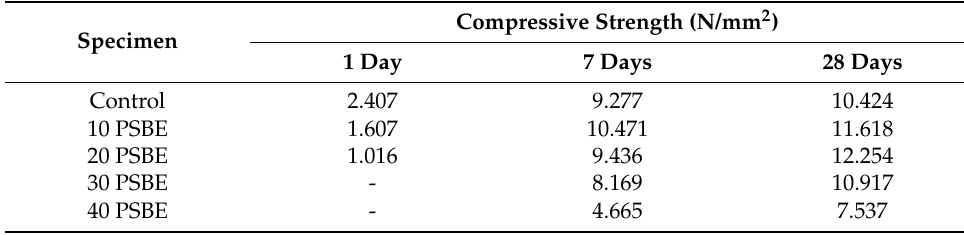
Table 5. Compressive strength test